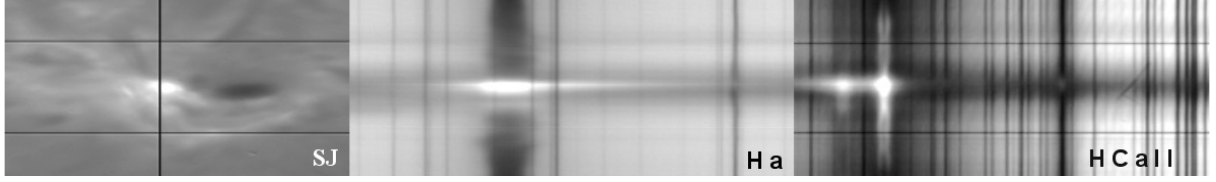
Figure 5. Flare 2012-07-05, 10:46:47 UT, from left to right: SJ, H α , H CaII in AR NOAA 11515.